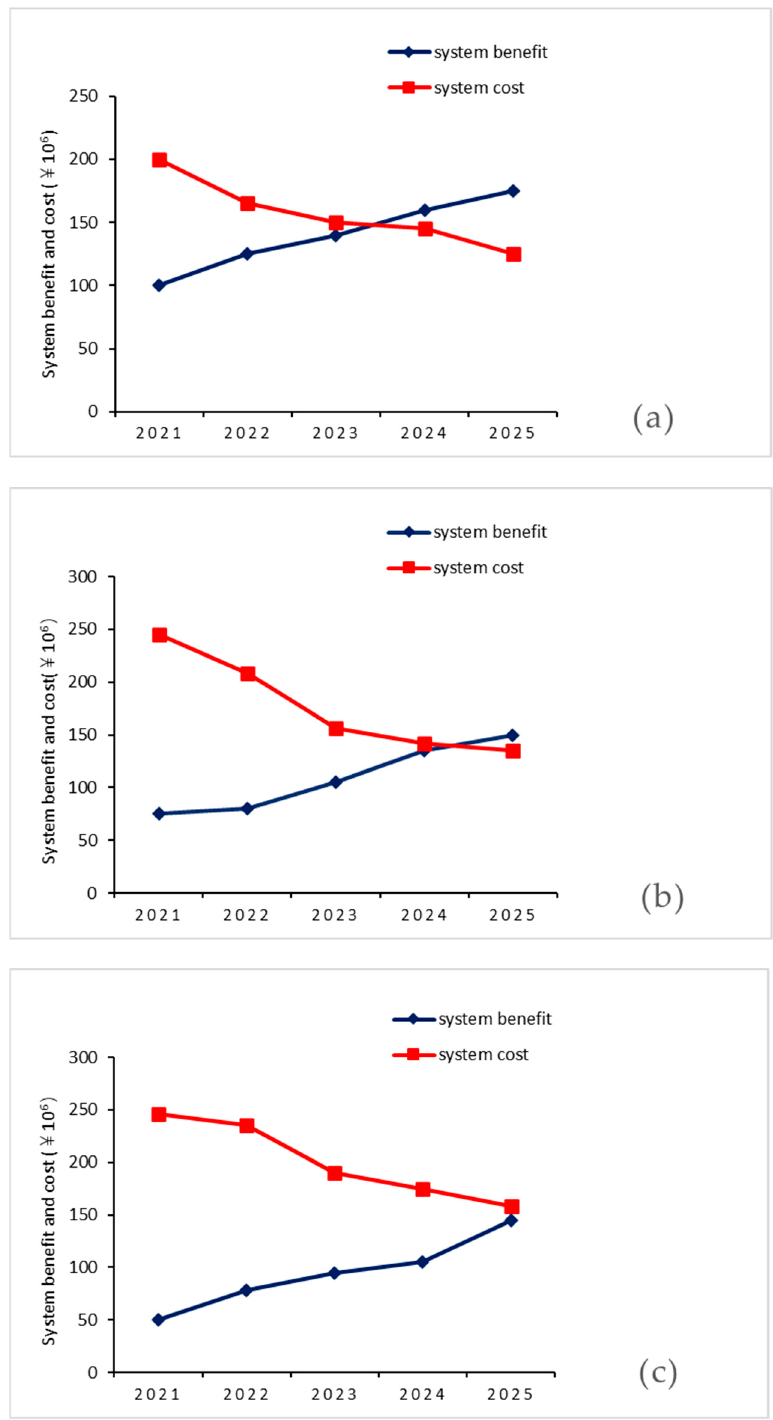
Figure 5. System benefit and cost in 2021–2025 under different SSPs.